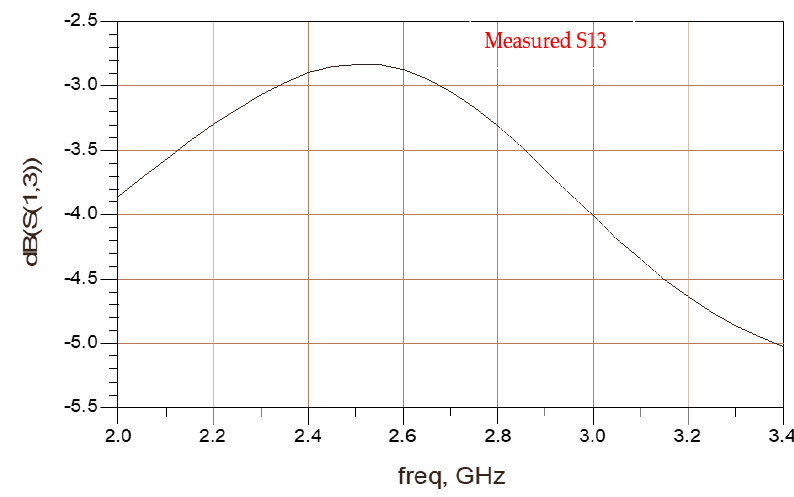
Figure 6. The branch line coupler measured S13 transfer parameter.